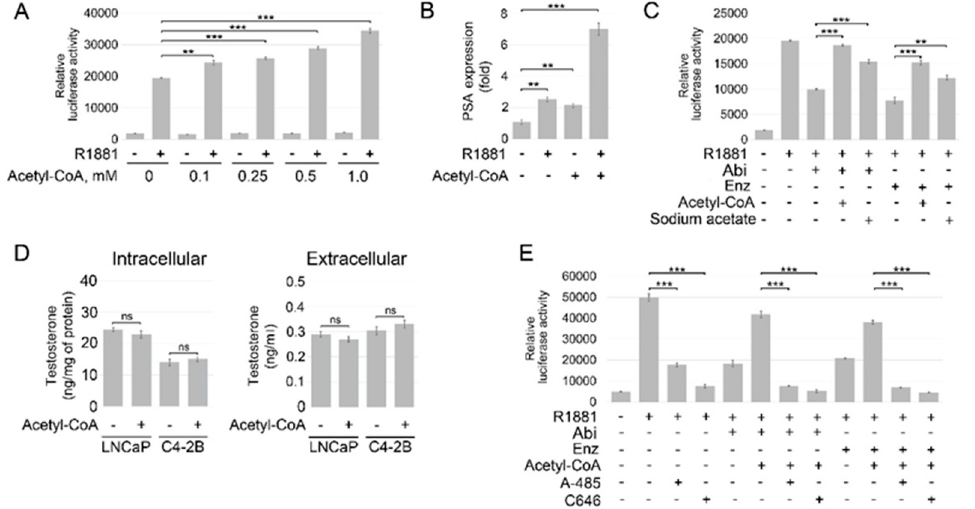
Figure 2. Acetyl-CoA diminishes the inhibitory effect of abiraterone and enzalutamide on AR signaling. ( A ) LNCaP cells were transfected with pGL3-AR-luc and phRL-TK plasmids and cultured under androgen-depleted conditions for 24 h followed by treatment with R1881 (1 nM) and the indicated concentrations of acetyl-CoA for 16 h. Samples were assayed for firefly and renilla luciferase activities using the Dual-Glo Luciferase assay. Values were normalized to Renilla activities. ( B ) LNCaP cells were cultured under androgen-depleted conditions for 24 h followed by treatment with R1881 (1 nM) and acetyl-CoA (0.5 mM) for 6 h. Gene expression was assayed by qRT-PCR. The 18S gene was used for normalization. ( C ) LNCaP cells were transfected with pGL3-AR-luc and phRL-TK plasmids and cultured under androgen-depleted conditions for 24 h followed by treatment with enzalutamide (Enz) (1 μ M), abiraterone acetate (5 μ M) (Abi), R1881 (1 nM), sodium acetate (10 mM), and acetyl-CoA (0.1 mM) for 16 h. ( D ) LNCaP and C4-2B PC cells were cultured under androgen-depleted conditions for 24 h followed by treatment with acetyl-CoA (0.1 mM) for 48 h. Expression of testosterone in cell lysates and cell culture supernatants was examined using a testosterone ELISA kit (Cayman Chemical). ( E ) Aliquots of LNCaP cells described in Panel C were pre-treated with or without p300/CBP inhibitors A-485 (1 μ M) or C646 (25 μ M). Results are expressed as the mean ( n = 3) ± SD. * p < 0.01; ** p < 0.001; *** p < 0.0001; ns—non-significant.